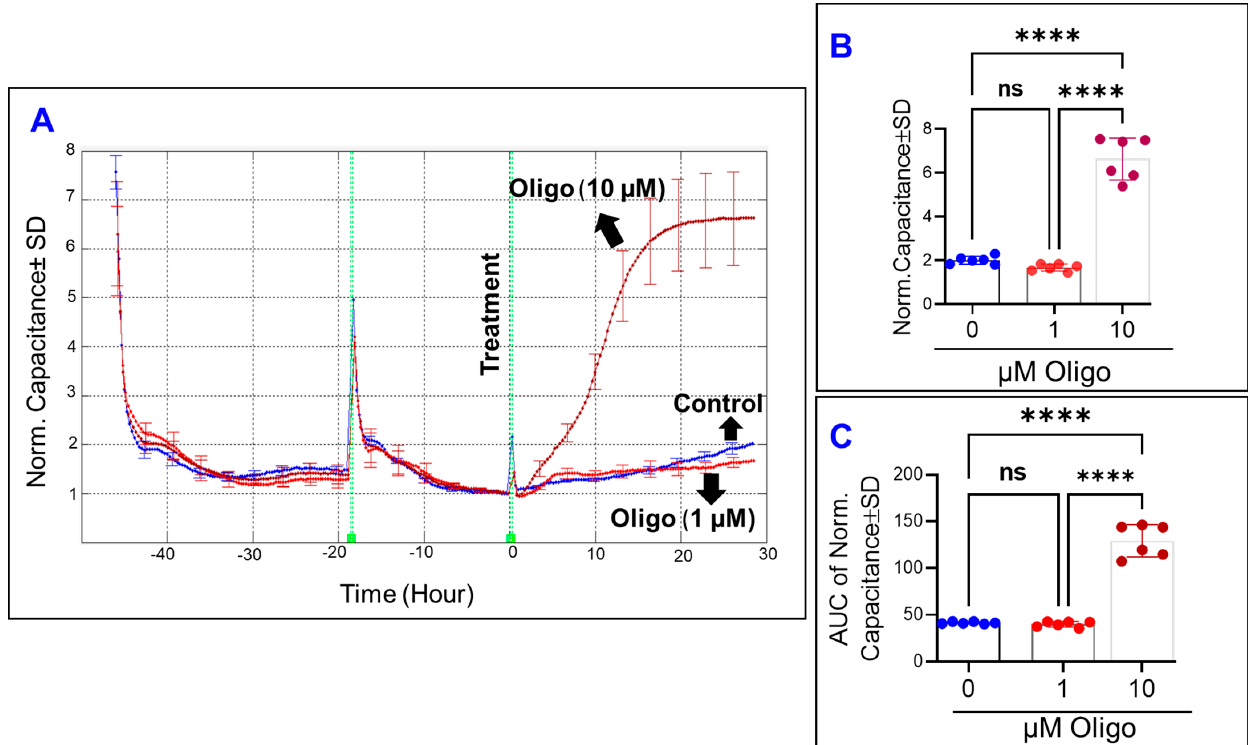
Figure 5. Real-time measurement of human retinal endothelial cells’ spreading capacity treated with an ATP synthase inhibitor (Oligomycin; Oligo). ( A ) The spreading of HRECs across the electrode after treatment with vehicle (DMSO) or Oligo (1 and 10 µM) was represented by plotting normalized capacitance vs. time, measured at an AC frequency of 64,000 Hz. The capacitance value at time 0 (C 0 ) was used to normalize all other capacitance measurements. ( B ) The bar graph represents normalized capacitance measured at t = 30 h. ( C ) AUC of normalized capacitance measure at the time interval between 0 and 30 h. Data were analyzed by the ANOVA test followed by the Tukey post hoc test. Abbreviations: Norm, normalized; AUC, area under the curve; ****, p ≤ 0.0001; ns, no significance.